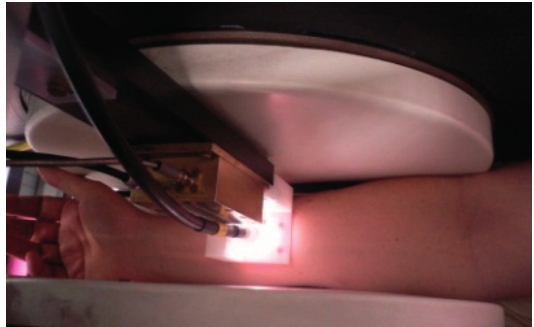
Figure 1. In vivo EPR system with in situ fiber-guided radiation of a solar simulator.